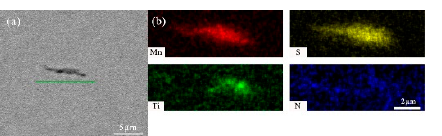
Figure 12. MnS with oxide as the nucleus ( a ) SEM morphology of inclusions; ( b ) composition distribution of inclusions.